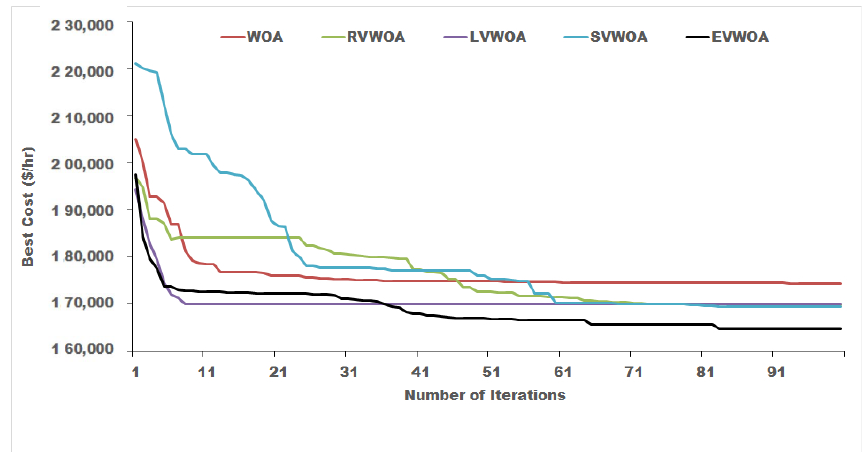
Figure 15. Convergence Curve for Case Study 6 obtained by WOA, RVWOA, LVWOA, SVWOA and